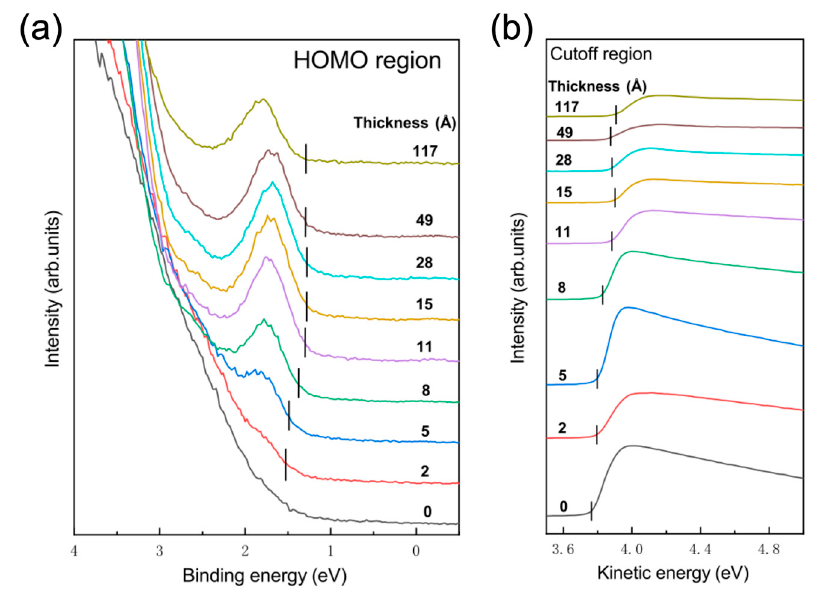
Figure 4. ( a ) The VB and ( b ) SECO spectra at the CuPc/CsPbI 2 Br interface.